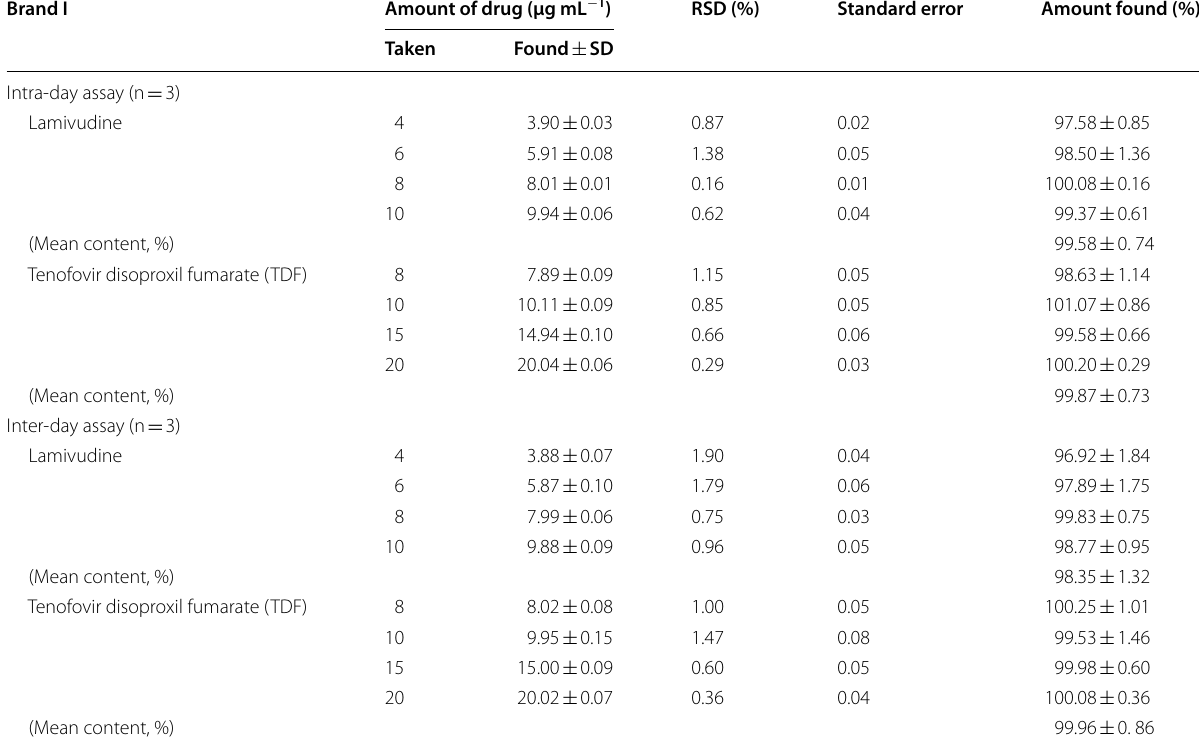
Table 2 Summary of precision and accuracy studies for third derivative spectroscopy